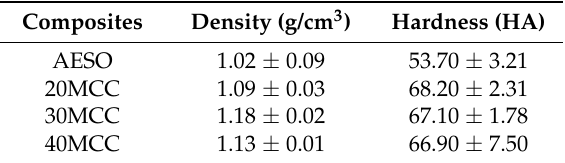
Table 1. Physical properties of pure AESO and MCC/AESO composites with different MCC